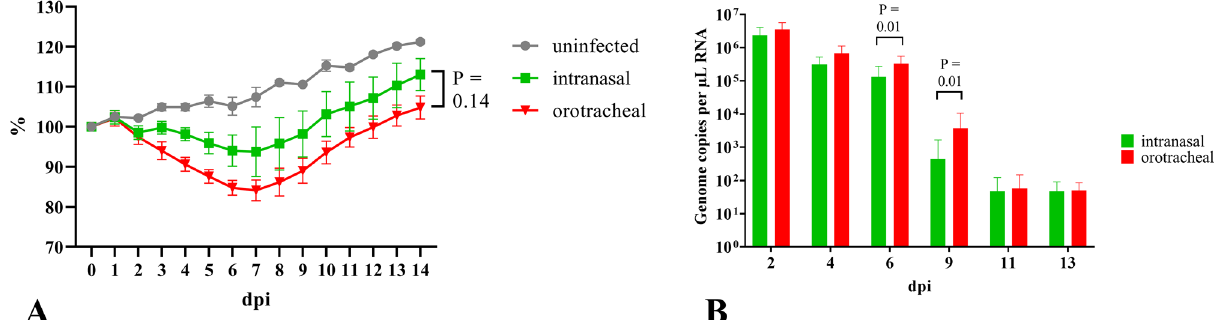
Figure 1. Orotracheal SARS-CoV-2 inoculation results in increased weight loss and viral shedding. ( A ) Body weight curves of uninfected control group (grey), groups infected by the nasal (green) and orotracheal (red) routes; ( B ) Nasal shedding between 1 and 13 dpi after intranasal (green) and orotracheal (red)